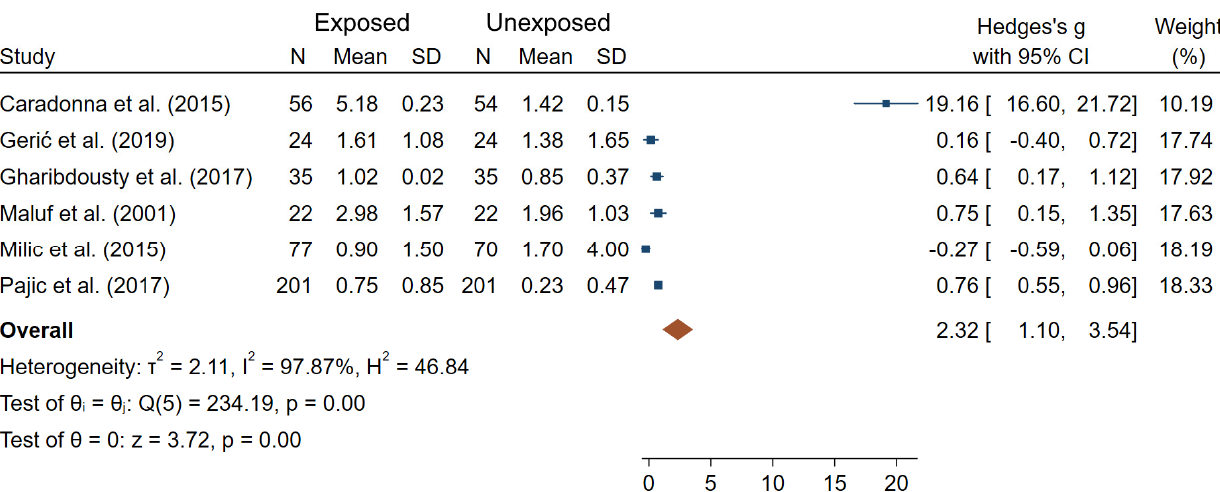
Figure 7. Forest plot of mean differences in SCE frequencies between IR exposed and unexposed workers. Lastly, the only two studies that focused on PCD reported significantly higher fre- quencies in IR-exposed workers compared to unexposed, regardless of a specific PCD readout used [49,64]. 3.2. DNA Integrity Biomarkers